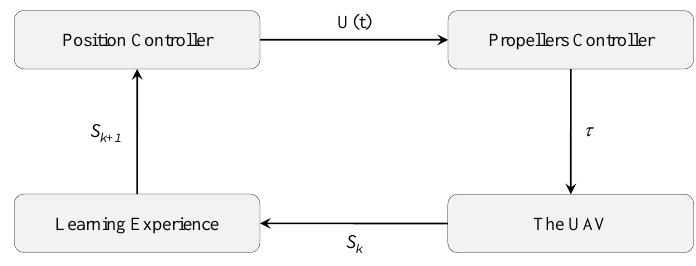
Figure 6. The proposed RL